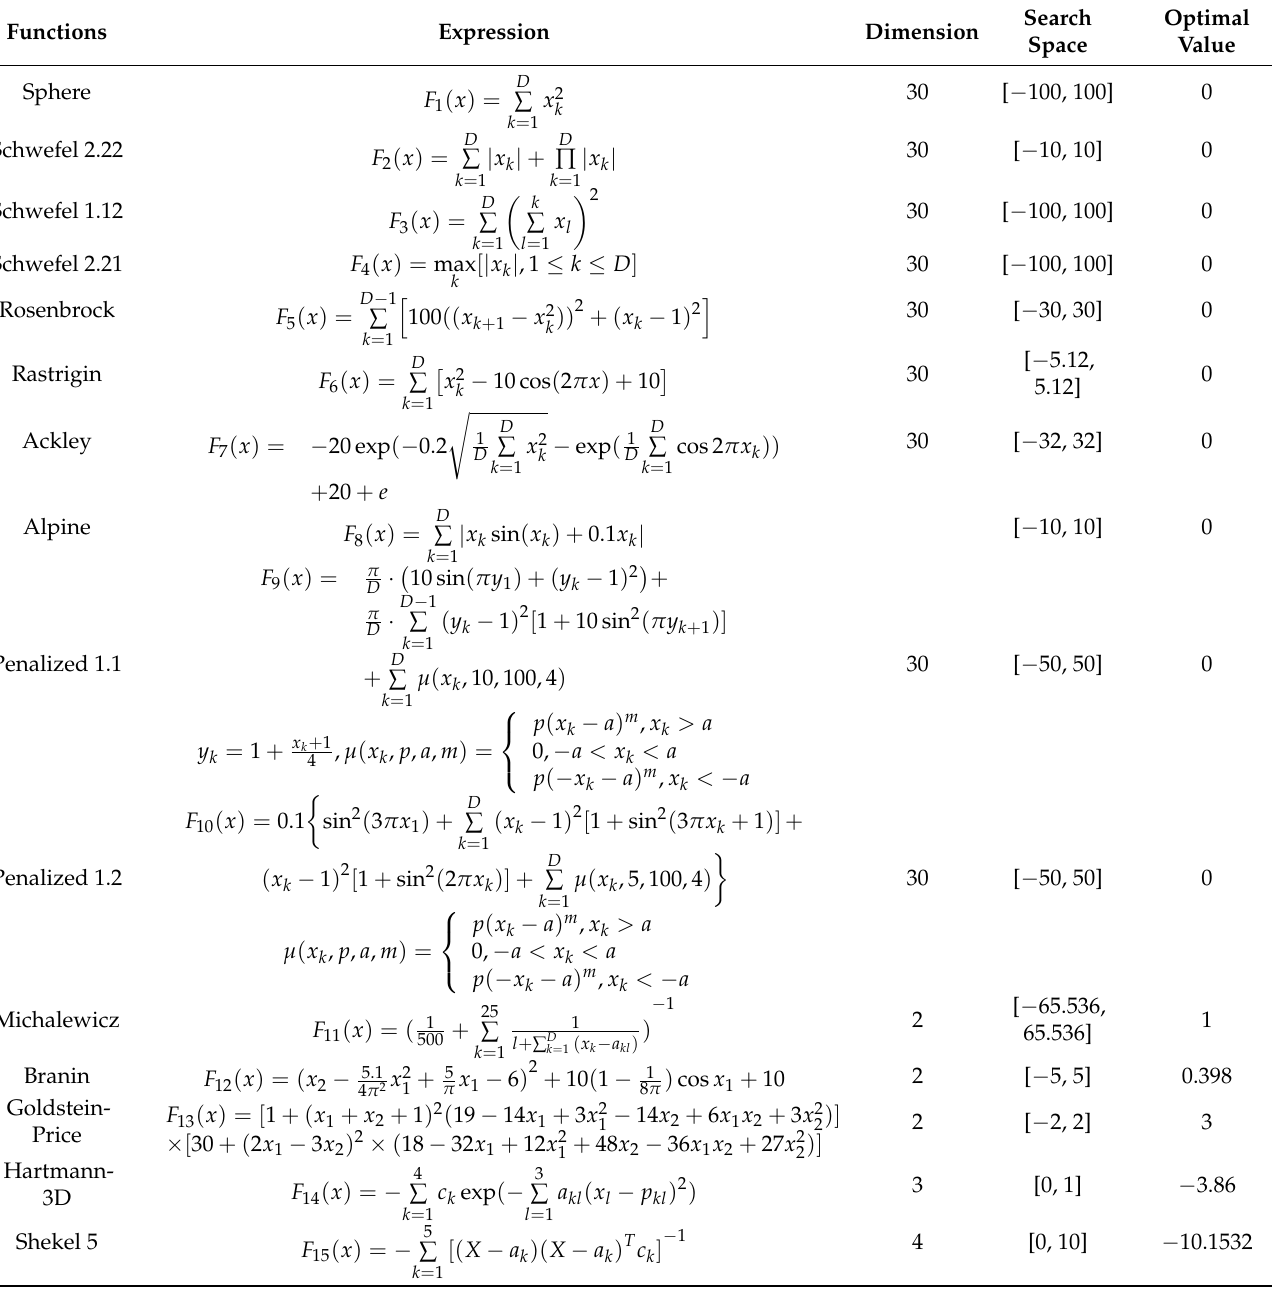
Table 2. Tested benchmark